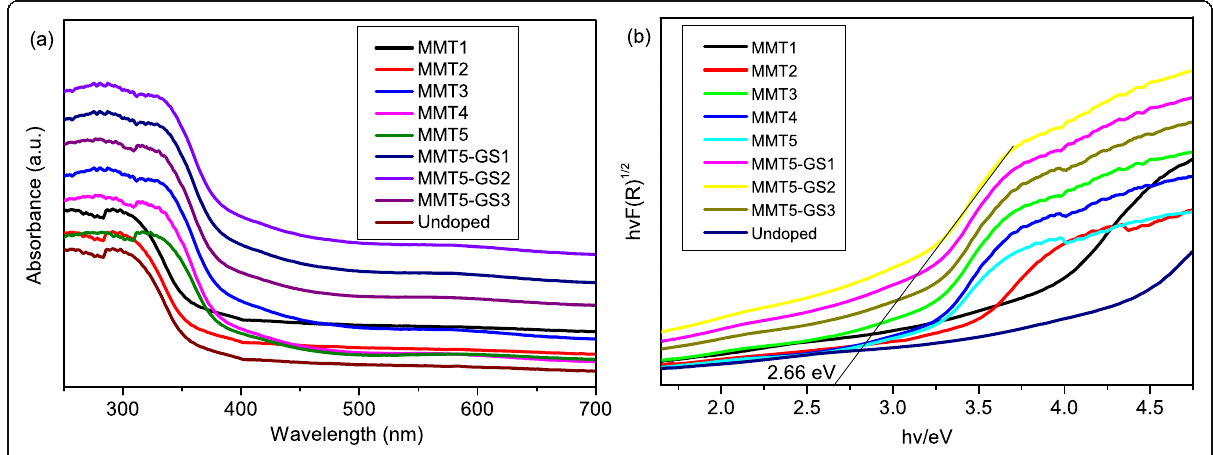
Fig. 3 a UV-Vis DRS and b Kubelka-Munk formalism spectra of undoped TiO 2 , MMT and MMT5-GS catalysts